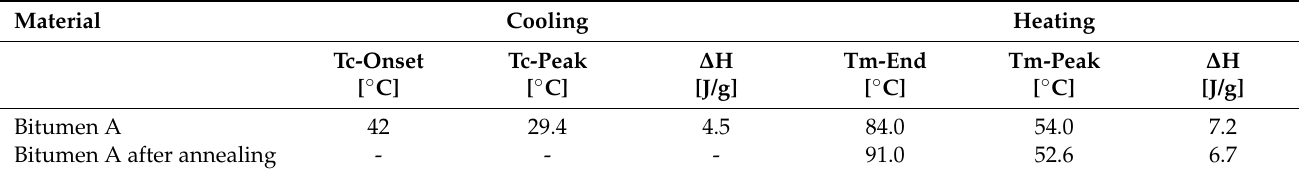
Table 2. Summary of DSC thermal transition data.